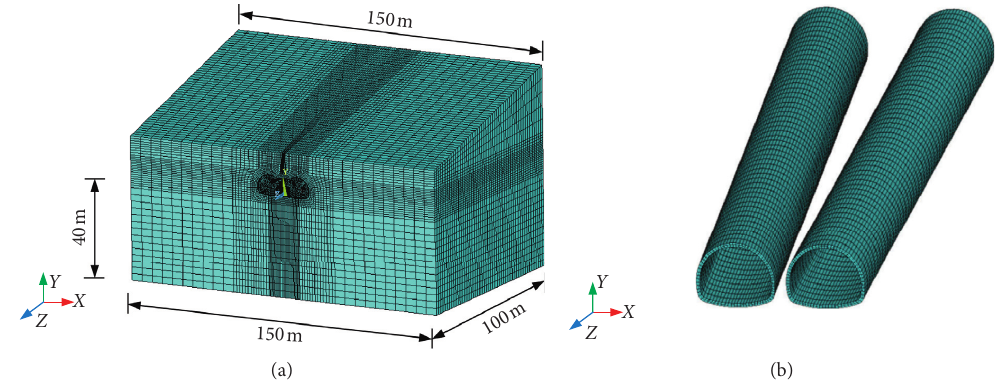
Figure 5: Calculation model and meshing: (a) overall calculation model; (b) tunnel lining model. Table 3: Parameters of explosive materials. Density (g/cm 3